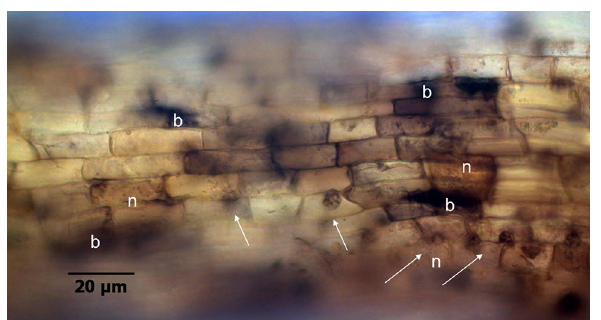
Figure 3. Proportions of structural damages in the outer root layers ( a ), and of the root hair status ( b ) in replant diseased fine roots of R. corymbifera ‘Laxa’, after 9 weeks of cultivation in untreated or γ-irradiated RRD soil from Heidgraben (H) in comparison to fine roots grown in RRD soil from Sangerhausen (S). Assessments separated into three (structural damage) and four symptom classes (root hairs), respectively, are given as observed proportions per plant (grey dots), mean proportions driven from the models (black dots), and 95% confidence intervals for the mean proportions (black bars) from 30 root segments of n = 4 plants. Significant difference (α = 0.05) were found in ( a ) for “destroyed” Sangerhausen untreated vs. Sangerhausen γ-irradiated (p = 0.0354) and in ( b ) for “many root hairs” Heidgraben untreated vs. Sangerhausen untreated (p = 0.0177). This figure was created using the software R version 3.6.1 (R Core Team 2019, https:// www.R- proje ct. org/) 48,51,52,54 .